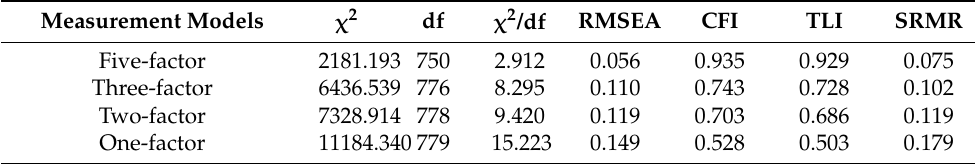
Table 1. Results of confirmatory factor analysis of the measurement models. Measurement